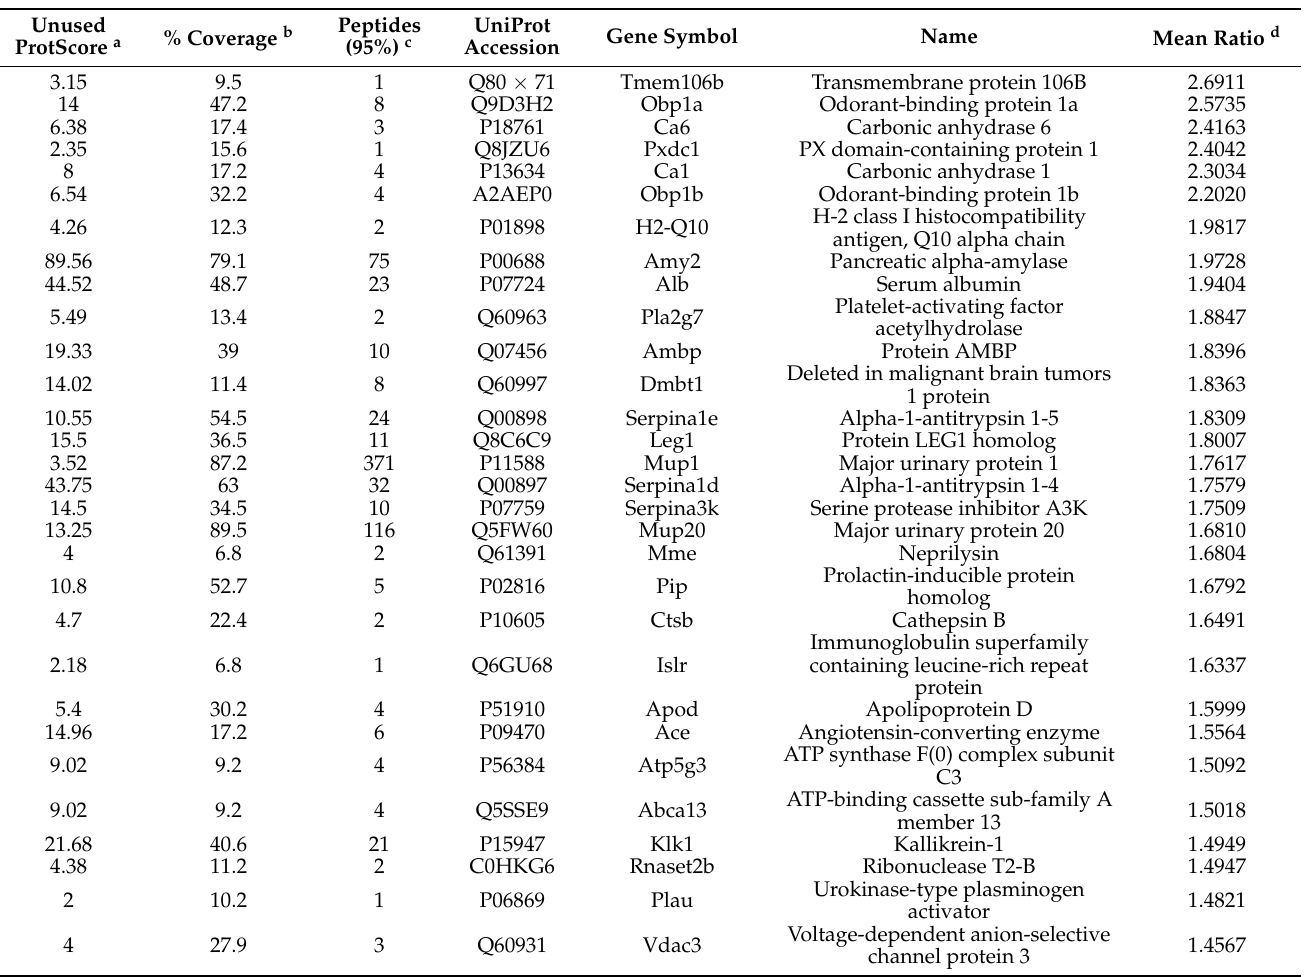
Table 1. The different proteins we identified in U-exo between WT and J20